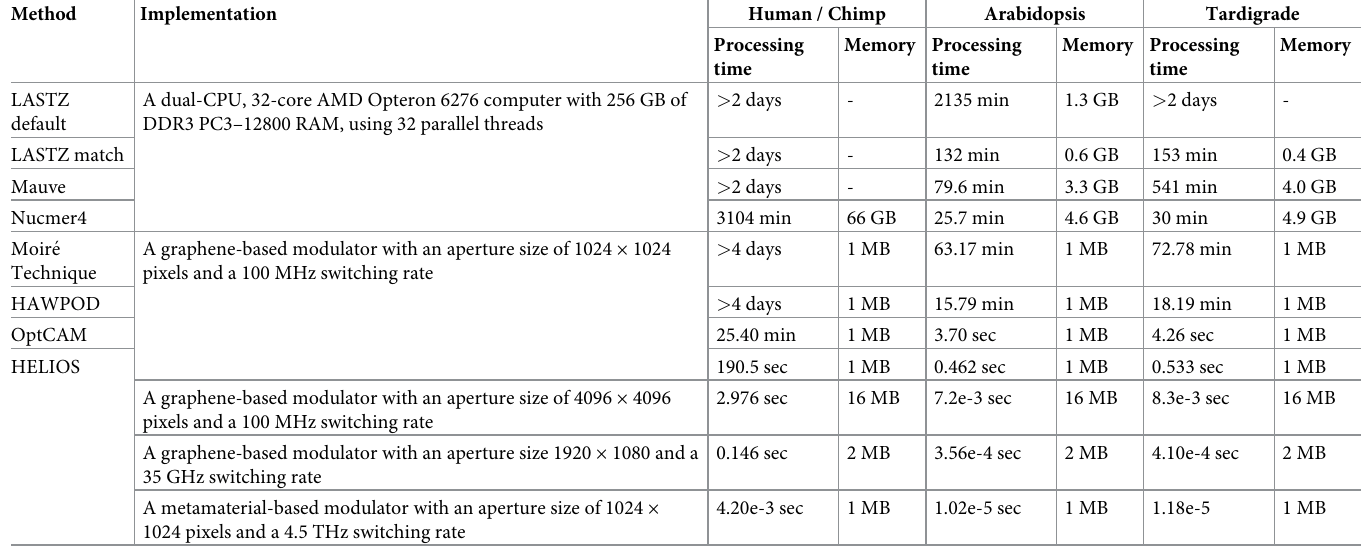
Table 18. Processing time and memory requirement of genome-to-genome alignment for the HELIOS optical architecture, compared to Nucmer4, Mauve, LASTZ default, LASTZ match, OptCAM, HAWPOD, and Moire´ Techniques. For these comparison scenarios, all reported timings for Nucmer4, Mauve, LASTZ default, and LASTZ match are measured on a dual-CPU, 32-core AMD Opteron 6276 computer with 256 GB of DDR3 PC3–12800 RAM, using 32 parallel threads. On the other hand, for the analytical estimation of the processing times of the HELIOS optical architecture, OptCAM, HAWPOD, and Moire´ Technique, a typical graphene-based modulator is considered with an aperture size of 1024 × 1024 pixels and a 100 MHz switching rate. Moreover, the processing times of the HELIOS optical architecture are reported for more recently developed modulators with various aperture sizes, such as 1920 × 1080 and 4096 × 4096 pixels, as well as various switching rates, including 35 GHz [72] and 4.5 THz [67]. It should be noted that the processing times reported for Nucmer4, Mauve, LASTZ default, and LASTZ match include Wall time and CPU time, while the HELIOS method is implemented within its optical architecture, and hence, the corresponding wall time is assumed